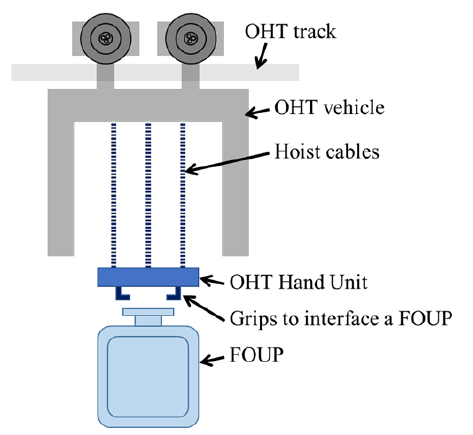
Figure 1. Schematic of the OHT vehicle, the OHT hand unit, and the FOUP interface.